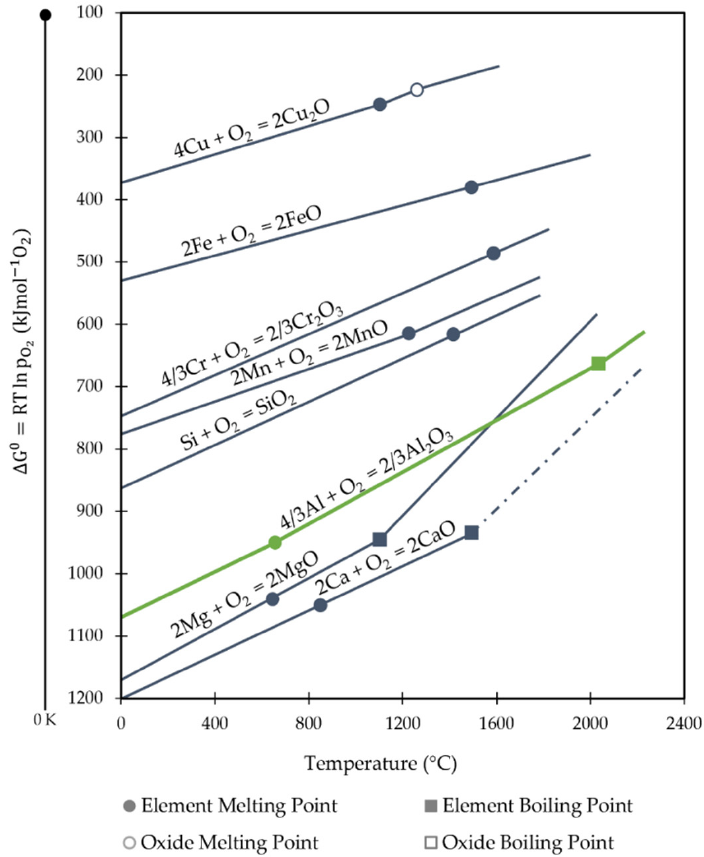
Figure 3. Ellingham diagram adapted from [45].